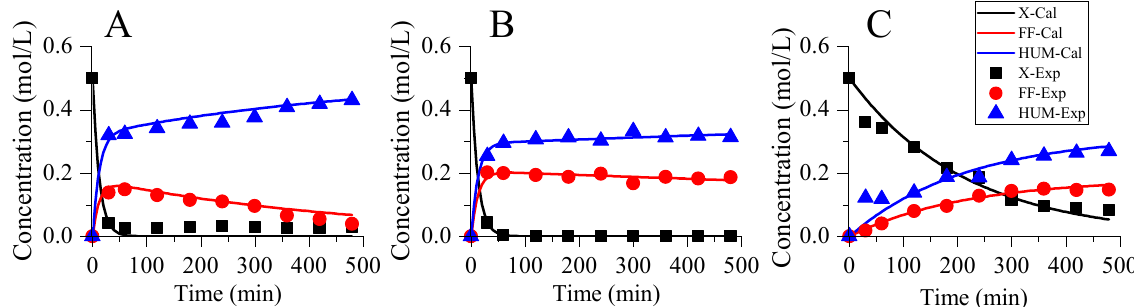
Figure 3. Kinetic plots of p TSA-catalyzed dehydration of xylose into furfural. Reaction conditions: 0.5 M xylose, 1.0 M p TSA, and 0.5 M CrCl 3 .6H 2 O catalysts in 50 mL solvents, ( A ) DMF at 120 °C; ( B ) DMSO at 120 °C; ( C ) water at 100 °C. Lines represent calculated data whereas symbols represent experimental values. X: xylose; FF: furfural; HUM; humin. Table 1. Fitted reaction parameters for xylose conversion into furfural in different solvent mediums. Reaction conditions: 0.5 M Xylose, 1.0 M p TSA, and 0.5 M CrCl 3 .6H 2 O catalysts in 50 mL solvent at 120 °C (water 100 °C) and stirring at 200 rpm for 8 h.